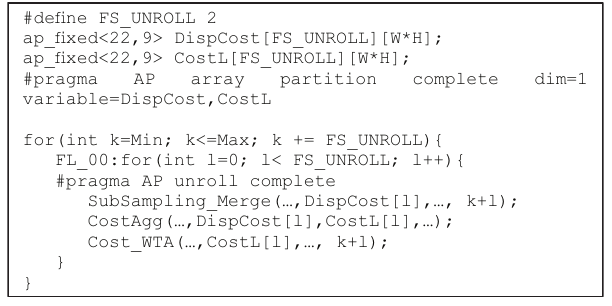
Figure 5: Code Example 3—array partition and complete loop unroll to expose functional